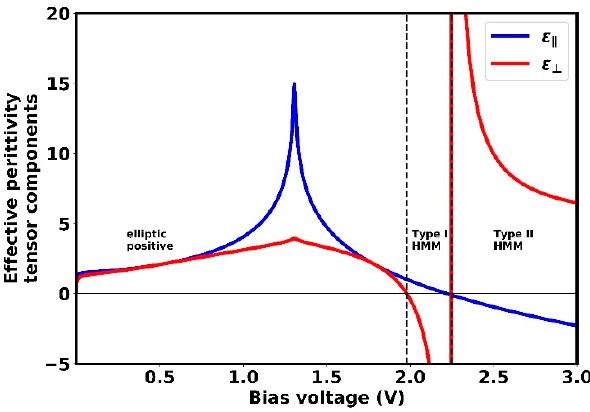
Figure 2. E ff ective permittivity tensor components of the guiding medium at 1.55 µ m dependent on the voltage bias V b applied. Three dispersion regions are indicated: positive elliptic (0 < V b < 1.98 V), type I hyperbolic metamaterial (HMM) (1.98 V < V b < 2.25 V) and type II HMM ( V b > 2.25